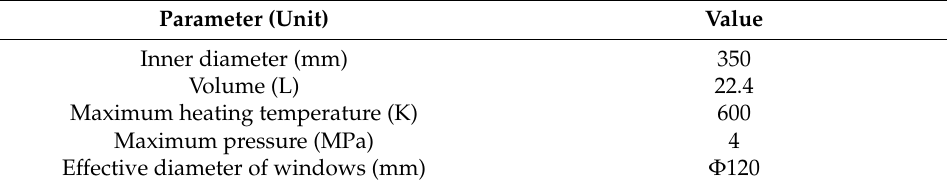
Figure 1. The experimental setup. Table 1. Basic parameters of the constant volume chamber (CVC).